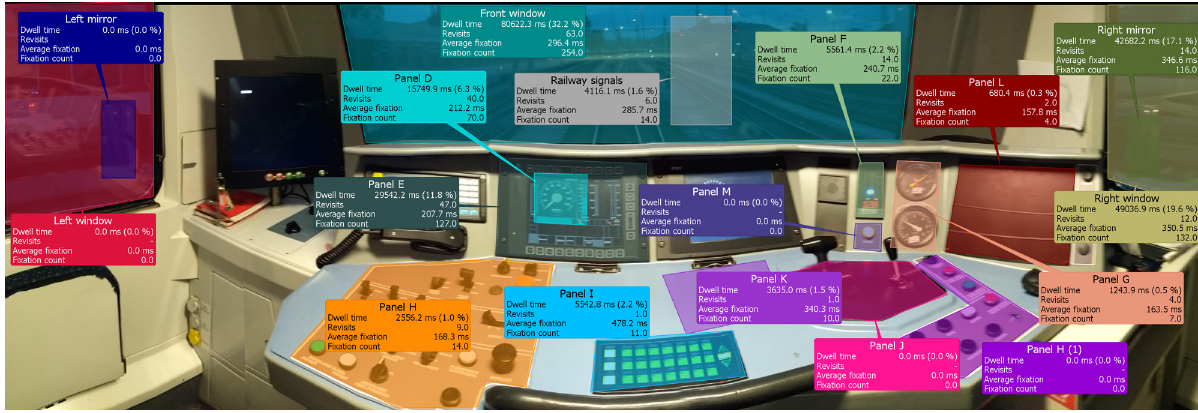
Figure 5: KPI analysis with BeGaze